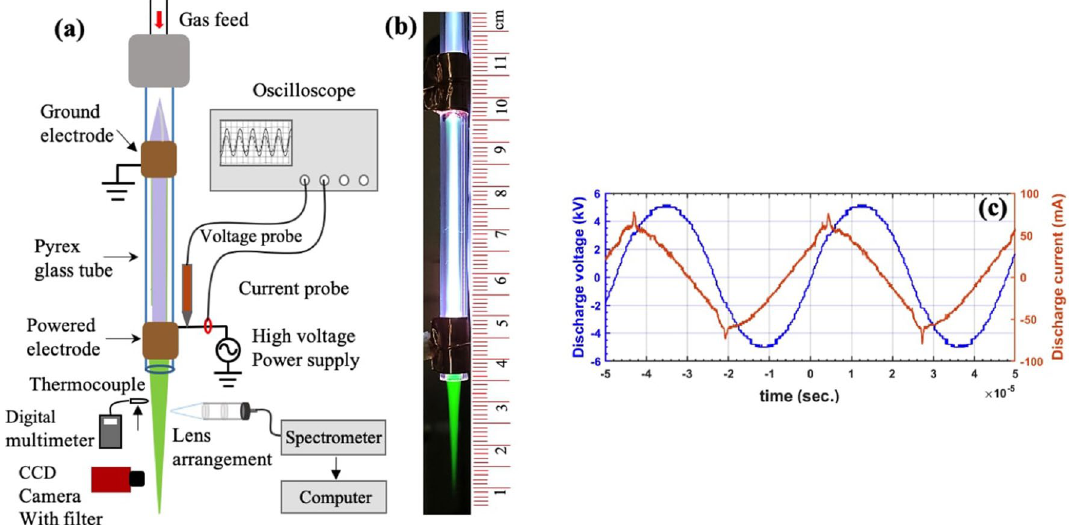
Figure 1. ( a ) Schematic diagram of the experimental setup. Diagnostics include optical emission spectroscopy, CCD camera, discharge voltage and current probes and multimeter with thermocouple. ( b ) Typical photograph of the APPJ. ( c ) Typical discharge voltage ( V d ) and current ( I d ) profiles of the plasma jet formed at f = 21kHz , V d = 10.2kV and gas flow rate Q Ar = 6sL/min